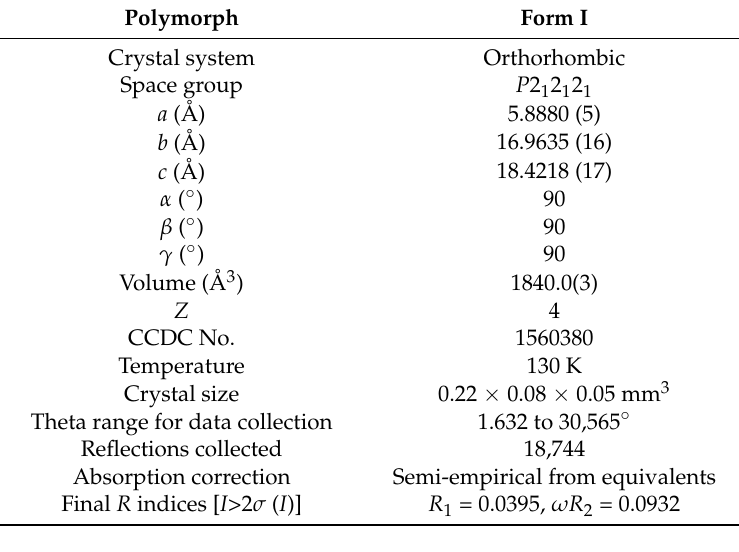
Table 1. Crystallographic information of famoxadone Form I.